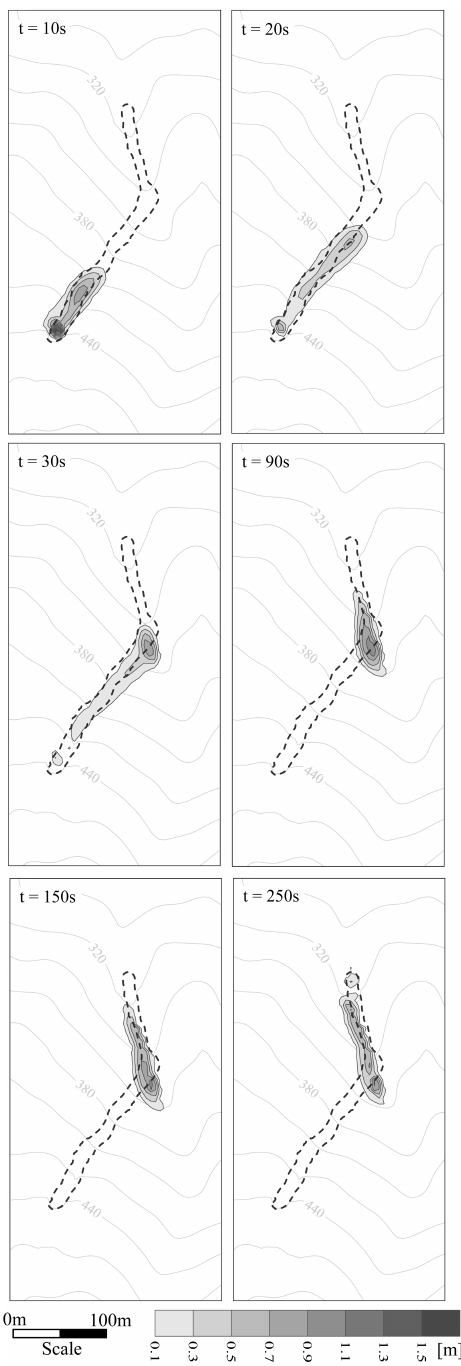
Fig. 5. The August 2005 debris flow – Filled depth contours of sliding debris (Voellmy rheology). The dotted line indicates the extent of the real event (propagation+deposit).